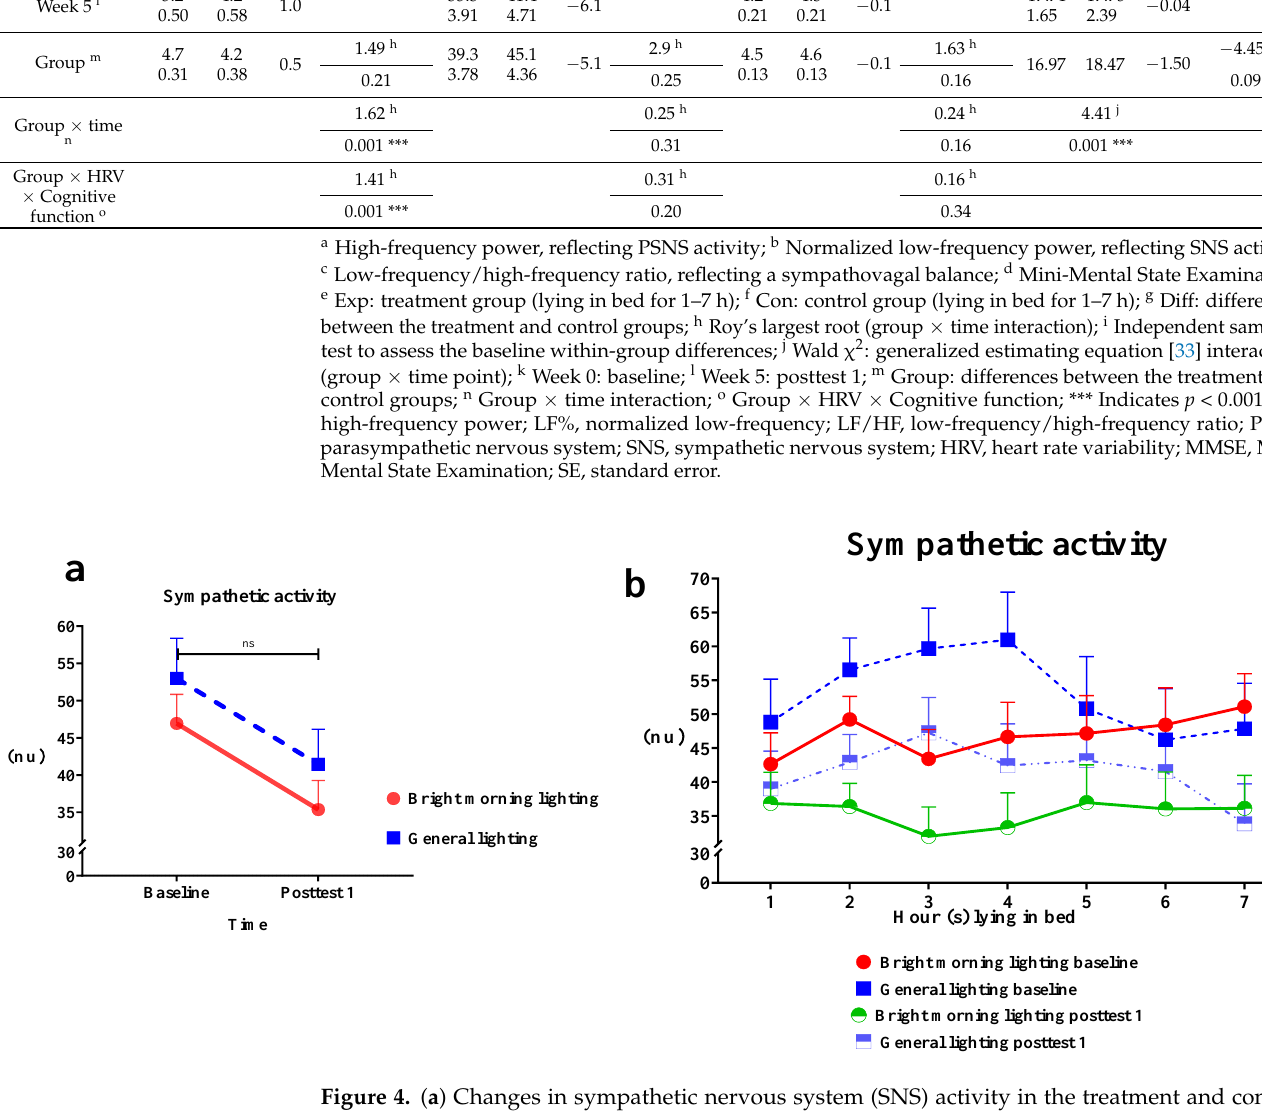
b Figure 5. ( a ) A nonsignificant decrease in the low-frequency/high-frequency (LF/HF) ratio of the treatment group ( p > 0.05). ( b ) The treatment group demonstrated a significant decrease in the low- frequency/high-frequency (LF/HF) ratio while lying in bed for 3 – 4 h, resulting in a U-shaped curve.